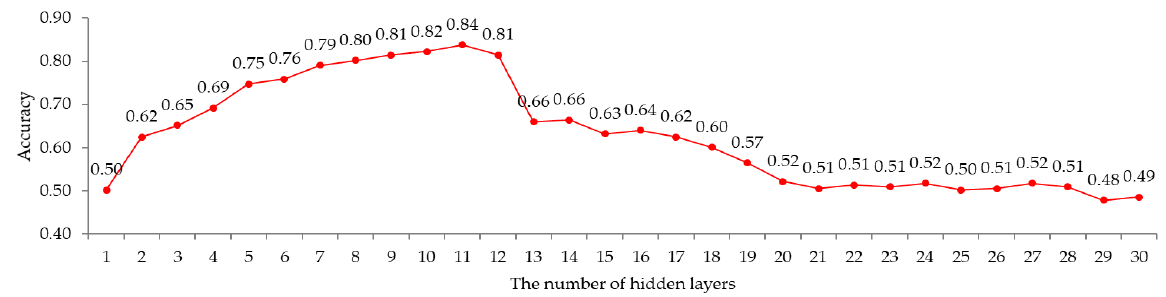
Figure 9. The accuracy of the RRPS and K-means.